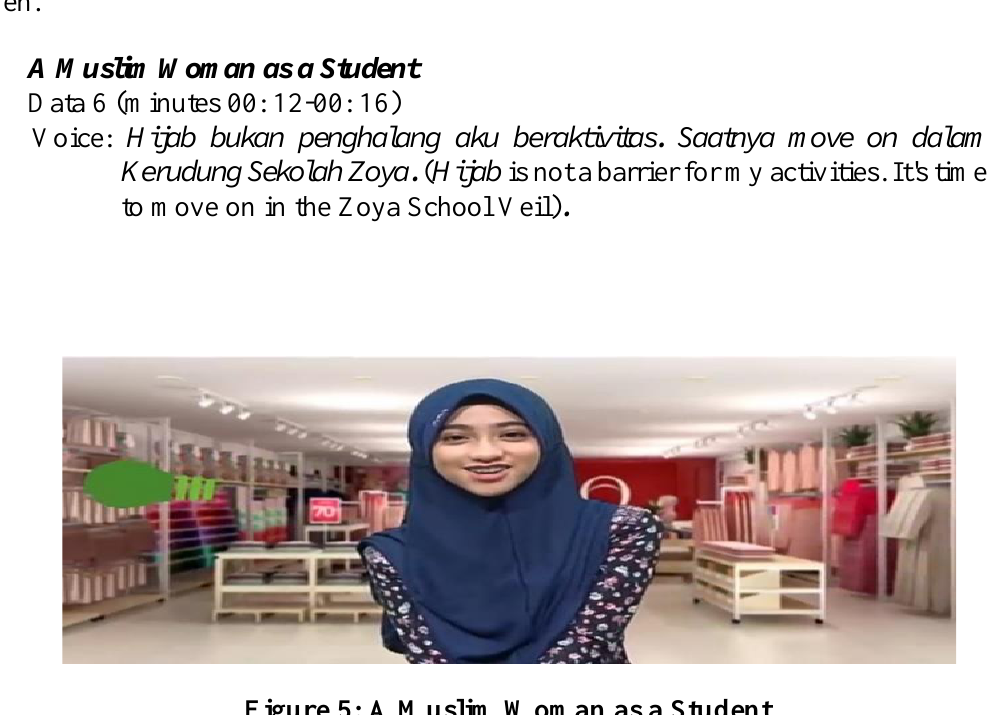
Figure 5: A Muslim Woman as a